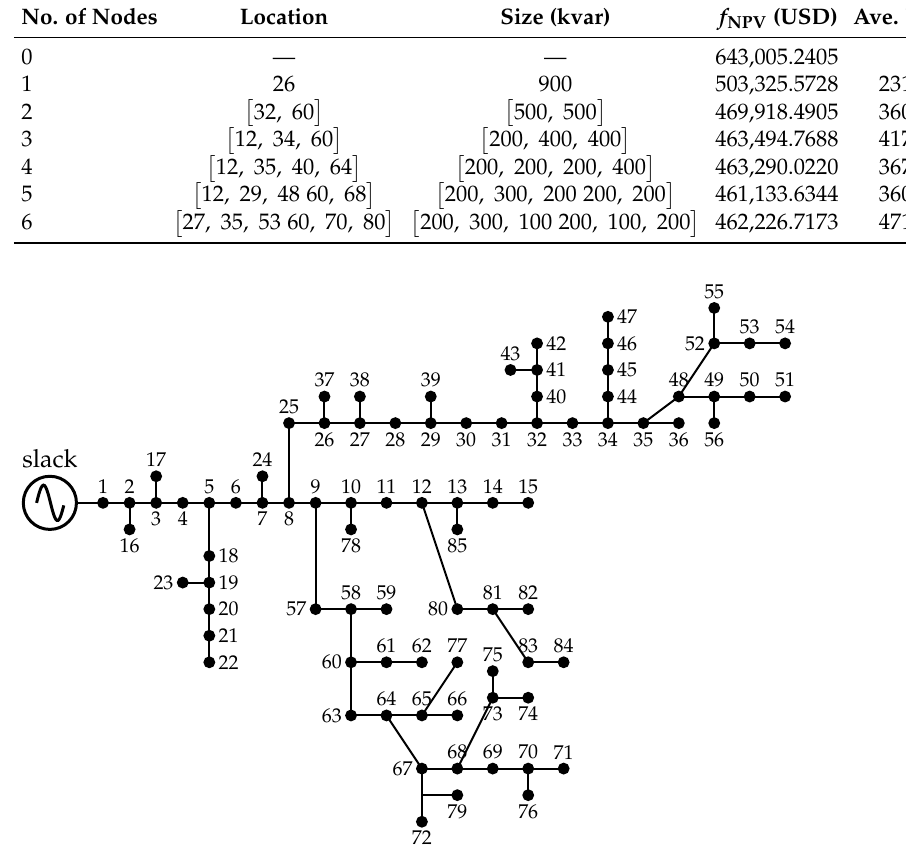
Figure 6. Schematic nodal connections of the IEEE 85-bus